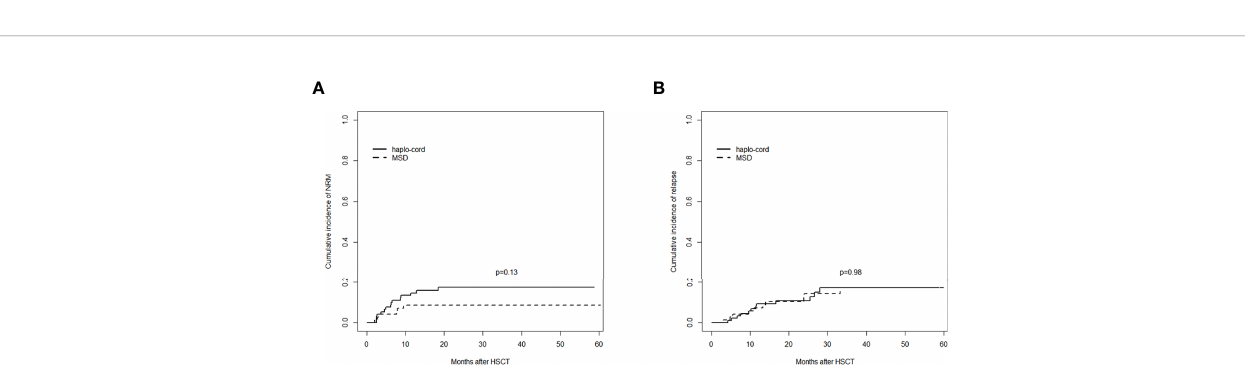
FIGURE 4 | Comparisons of outcomes between the haplo-cord group and the MSD group: (A) cumulative incidence of NRM and (B) cumulative incidence of relapse. MSD, matched sibling donor; NRM, non-relapse mortality. The multivariate analysis ( Table 2 ) showed no signi fi cant difference in the risk of relapse (HR = 0.947, 95% CI: 0.386 –